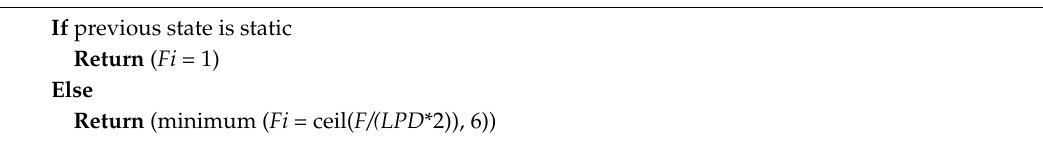
Algorithm 3. Adaptive filter frequency selector ( LPD